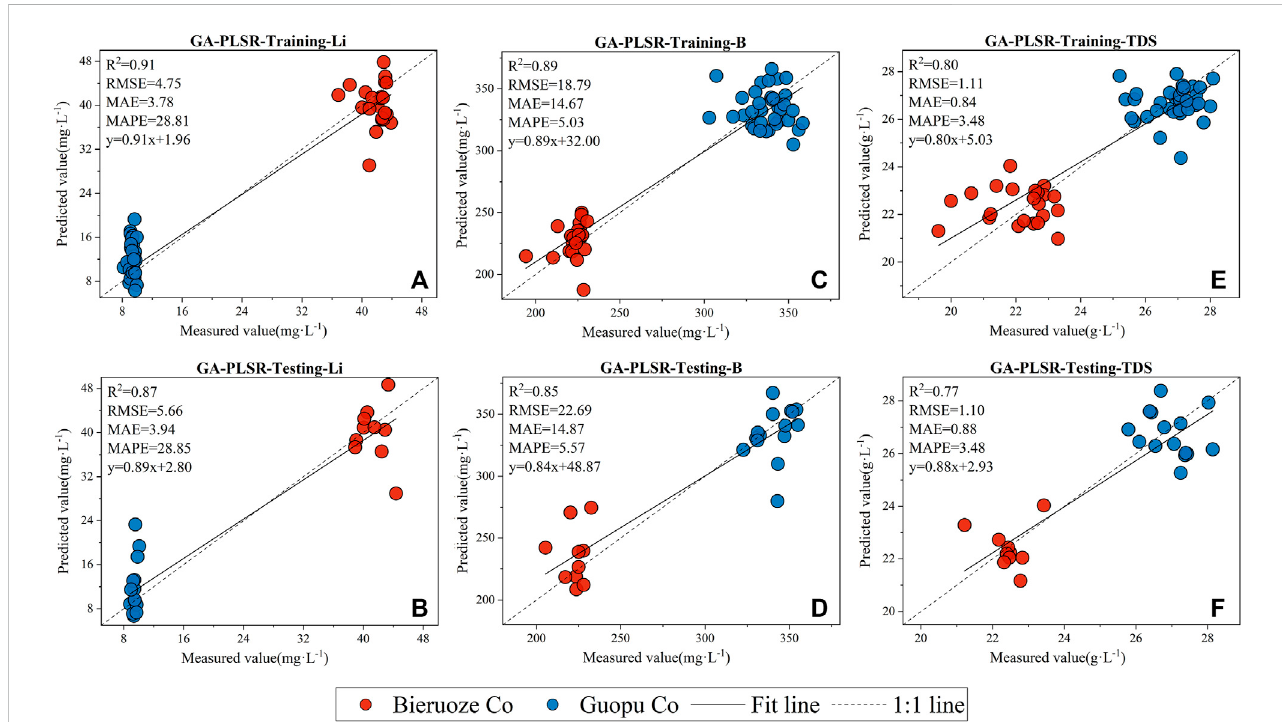
FIGURE 5 Fitting of measured and predicted values using GA-PLSR models. Estimated Li contents based on the training (A) and testing (B) . Estimated B contents based on the training (C) and testing (D) . Estimated TDS content during training (E) and testing (F) .